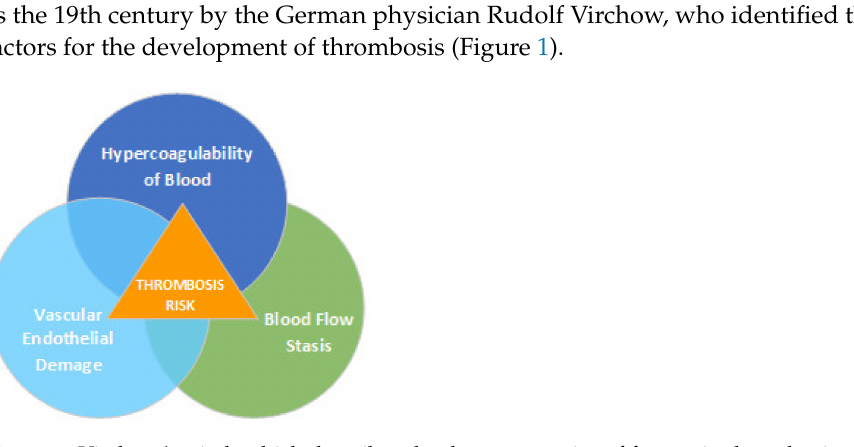
Figure 1. Virchow’s triad, which describes the three categories of factors in